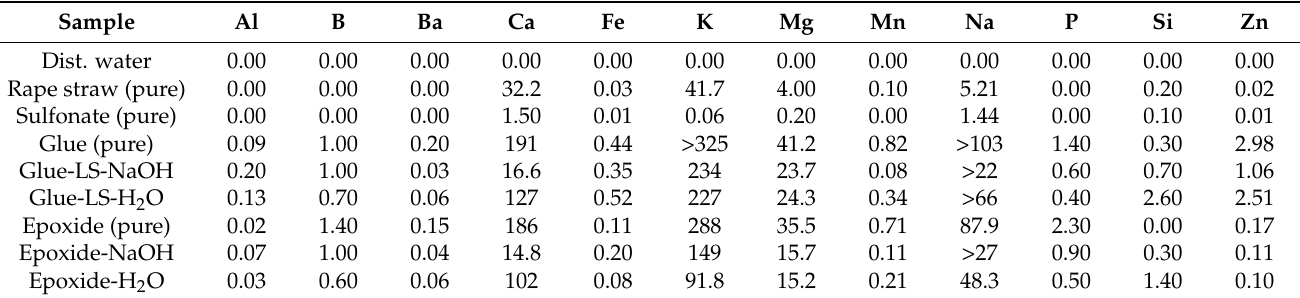
Table 2. Chemical analysis of the tested samples—their eluates (in ppm).